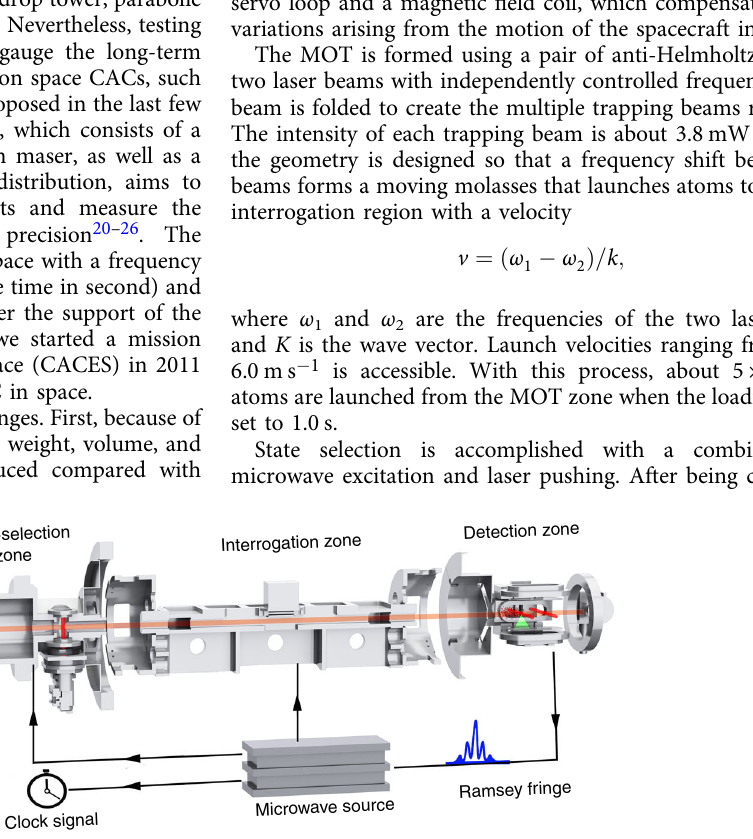
Fig. 1 Principle and structure of the space cold atom clock (CAC). The capture zone is a magneto-optical trap (MOT) with a folded beam design. The ring interrogation cavity is used for the microwave fi eld to interrogate the cold atoms. In the detection zone, cold atoms in both hyper fi ne states are detected. The clock signal is obtained by feeding the error signal to the frequency of microwave